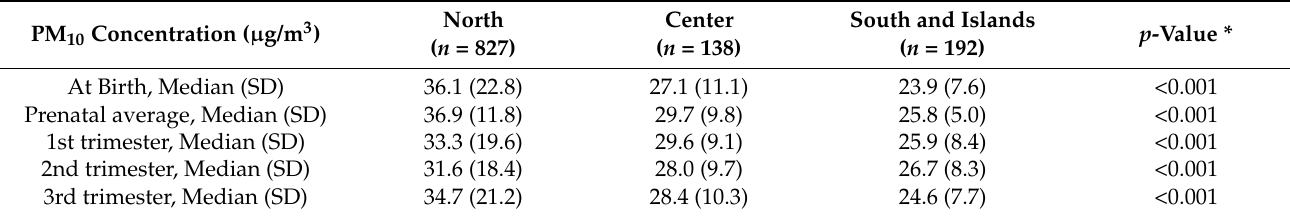
Table 2. PM 10 concentration at birth and during different periods of pregnancy by zone of residence.